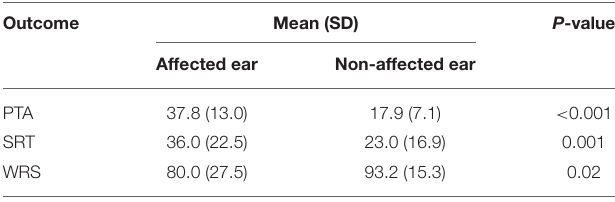
TABLE 3 | Statistical analysis of audiometric data between affected and non-affected